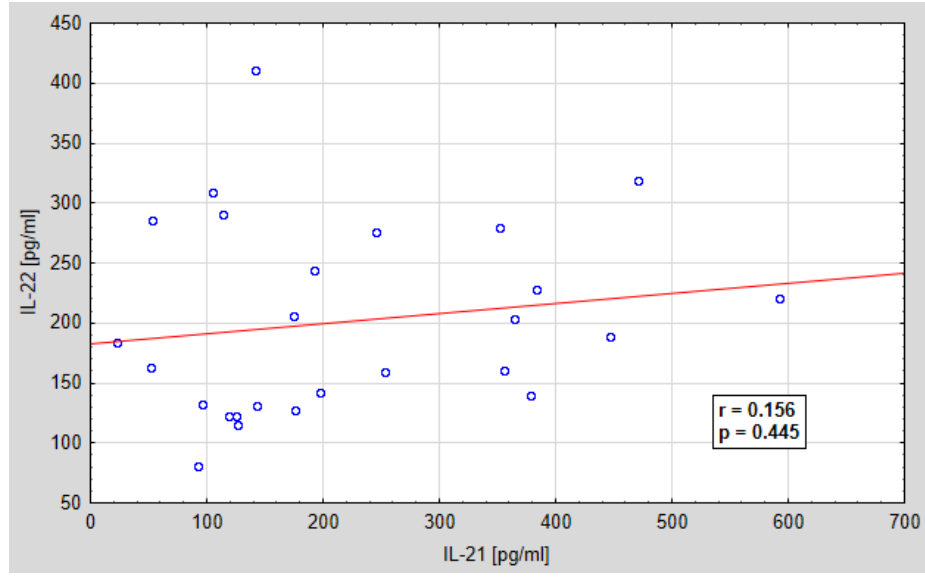
Figure 8. Linear regression curve showing the relationship between the concentration of Il-21 and IL-2 in the peritoneal fluid of women with ovarian cancer; r -correlation coefficient, p -probability value